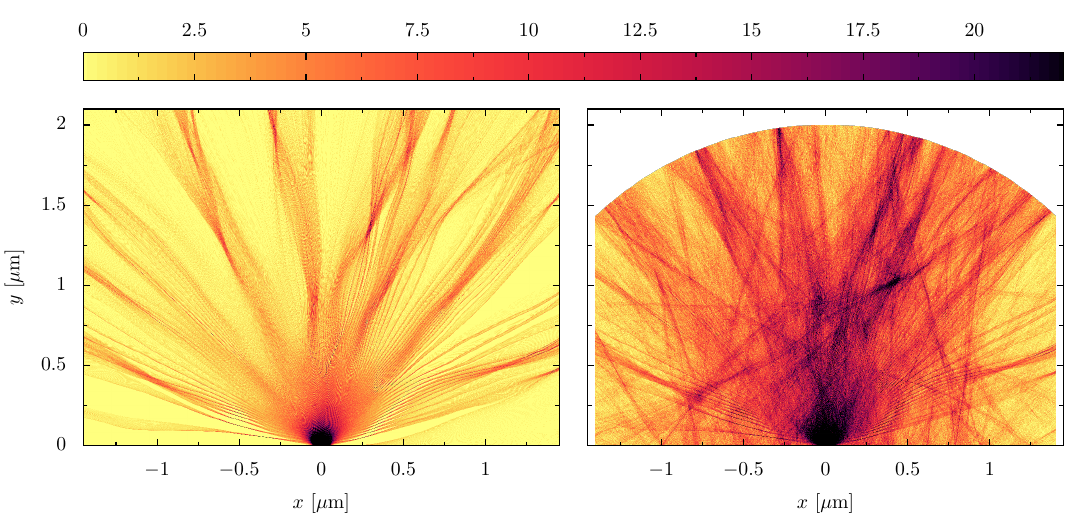
Figure 3: Density of classical trajectories for the same systems and disorder configu- ration as in Fig. 2. Left (right) panel: without (with) the cavity